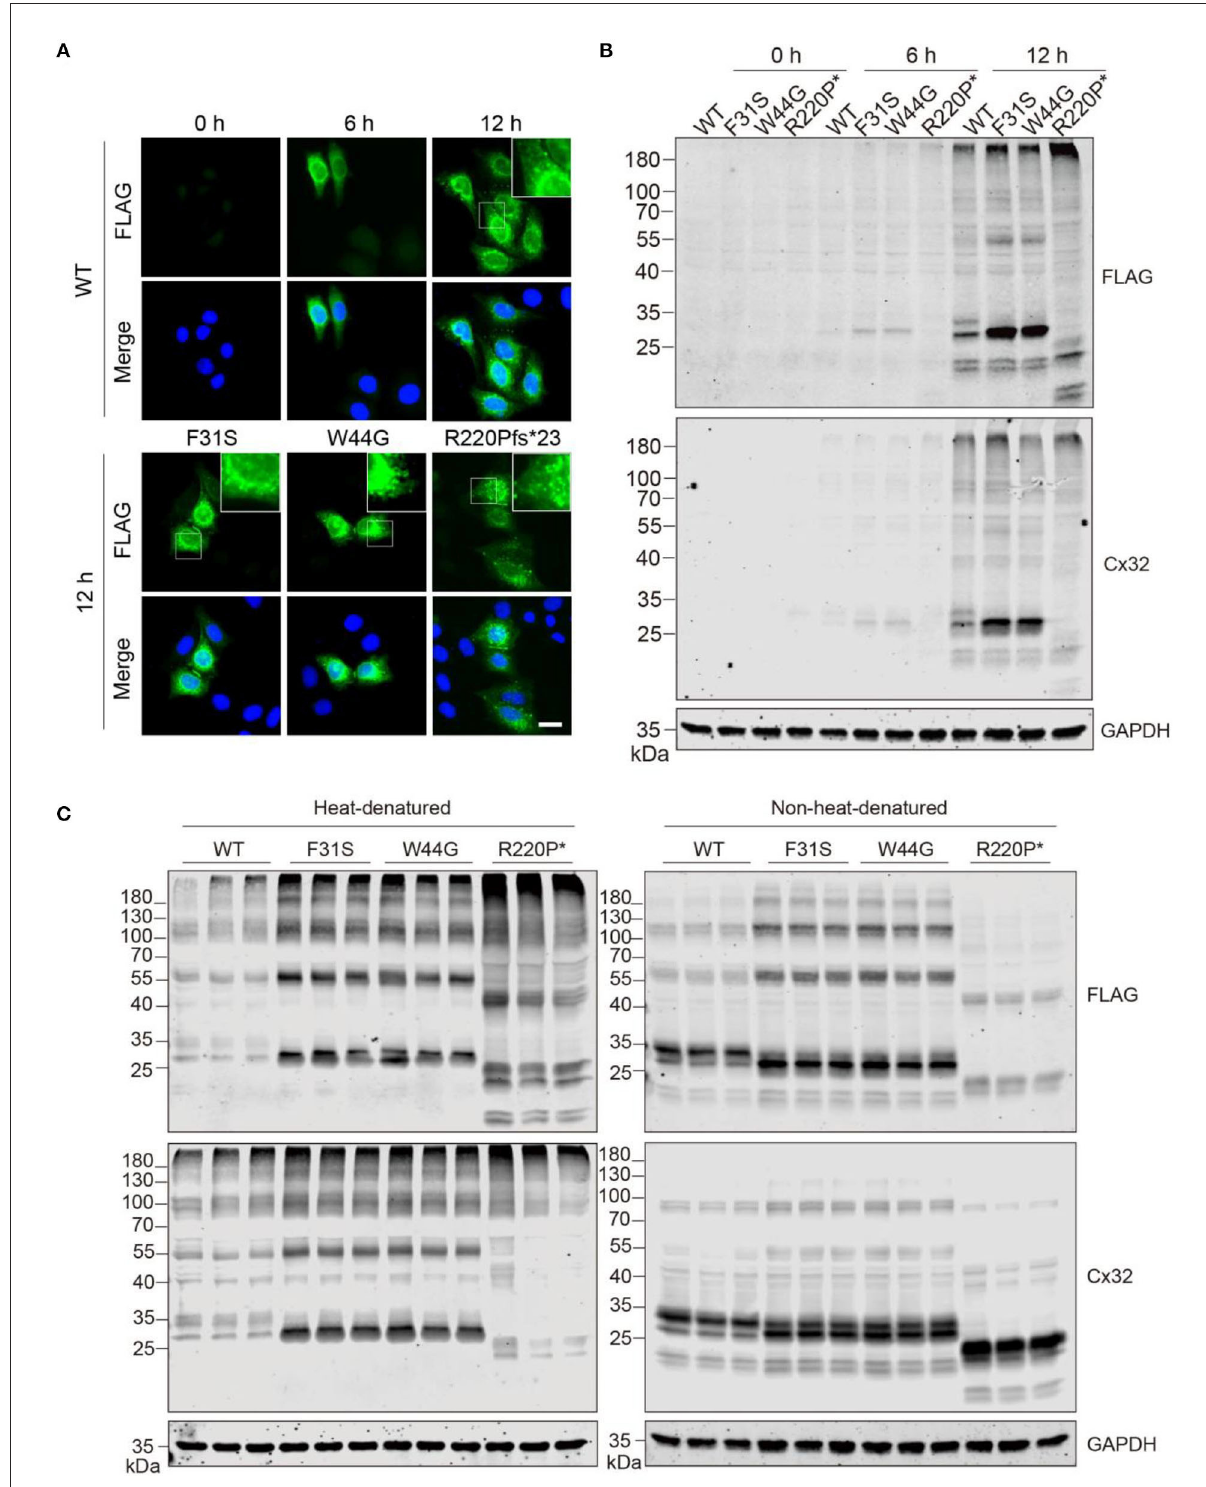
FIGURE3 GJB1 forms puncta-like condensates in cells when expressed at a low level. (A) Immunofluorescence staining of GJB1 in overexpressing HeLa cells at indicated time points after transfection. Stainings of cells transfected with mutants at 12h were shown. The top right boxes show an enlarged field. Blue, DAPI-labeled nuclei. Scale bar, 20 µ m. (B) Immunoblots of GJB1 expression in HeLa cell lysate after indicated transfection. Anti-FLAG and anti-Cx32 antibodies were used. R220P* is short for R220Pfs*23. (C) Immunoblots of GJB1 expression in HeLa cell lysate 24h after transfection. SDS sample buffer was used in the sample processing with or without heat-denaturation. Anti-FLAG and anti-Cx32 antibodies were used for